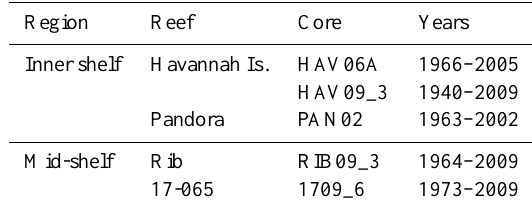
Table 1. Periods covered by coral core samples